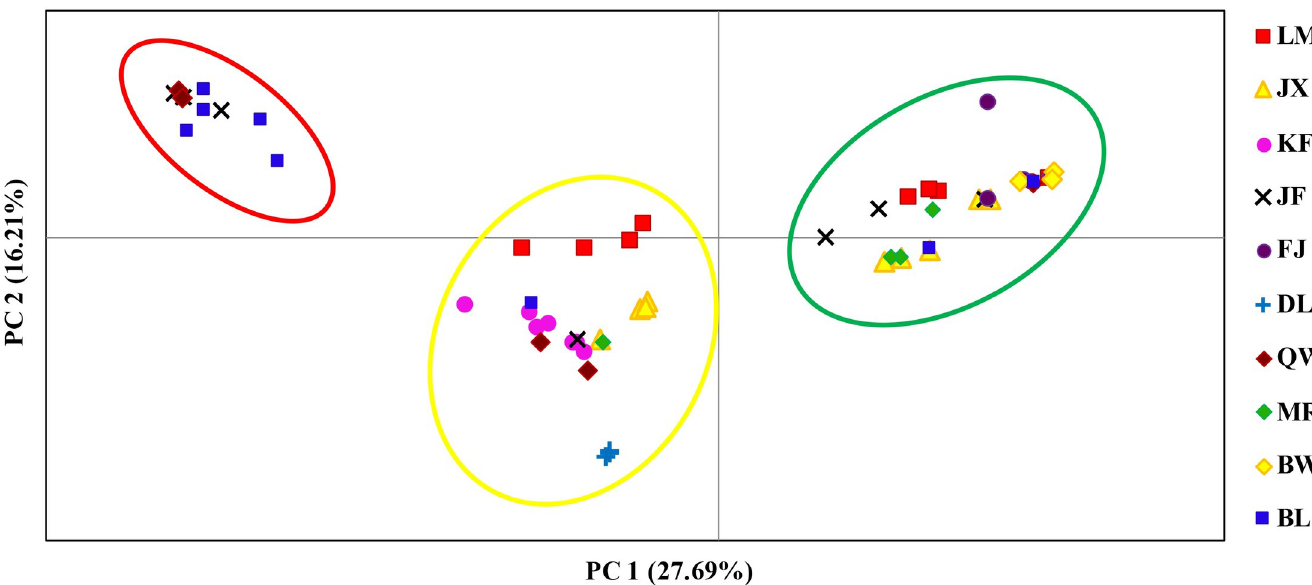
Fig 3. Principal coordinate analysis (PCoA) based on Cavalli-Sforza’s (1967) chord distance among individual samples of Hopea hainanensis . The three genetic groups identified by PCoA (highlighted by green, yellow and red ellipses) were consistent with the STRUCTURE results when K = 3.